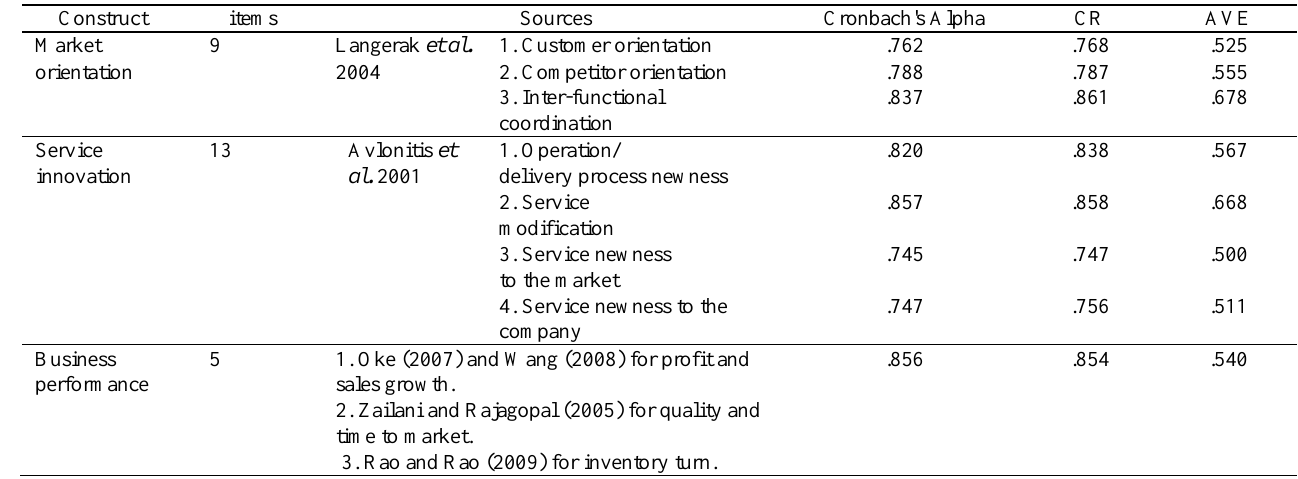
Table 1: Model construct, reliability and convergent